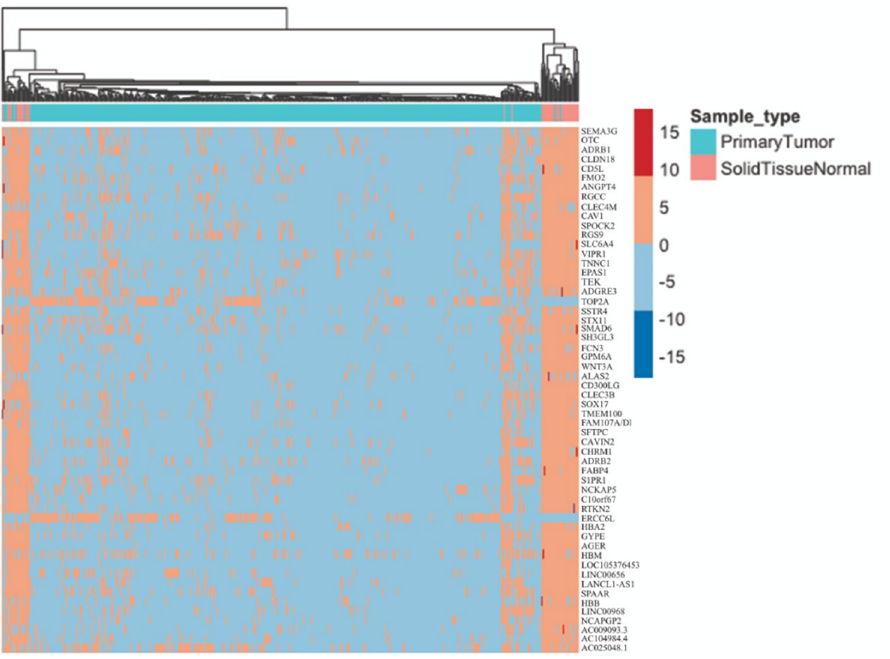
Fig 14. A heatmap representing the expression level of all genes obtained by at least two models. Red represents up-regulation and blue represents